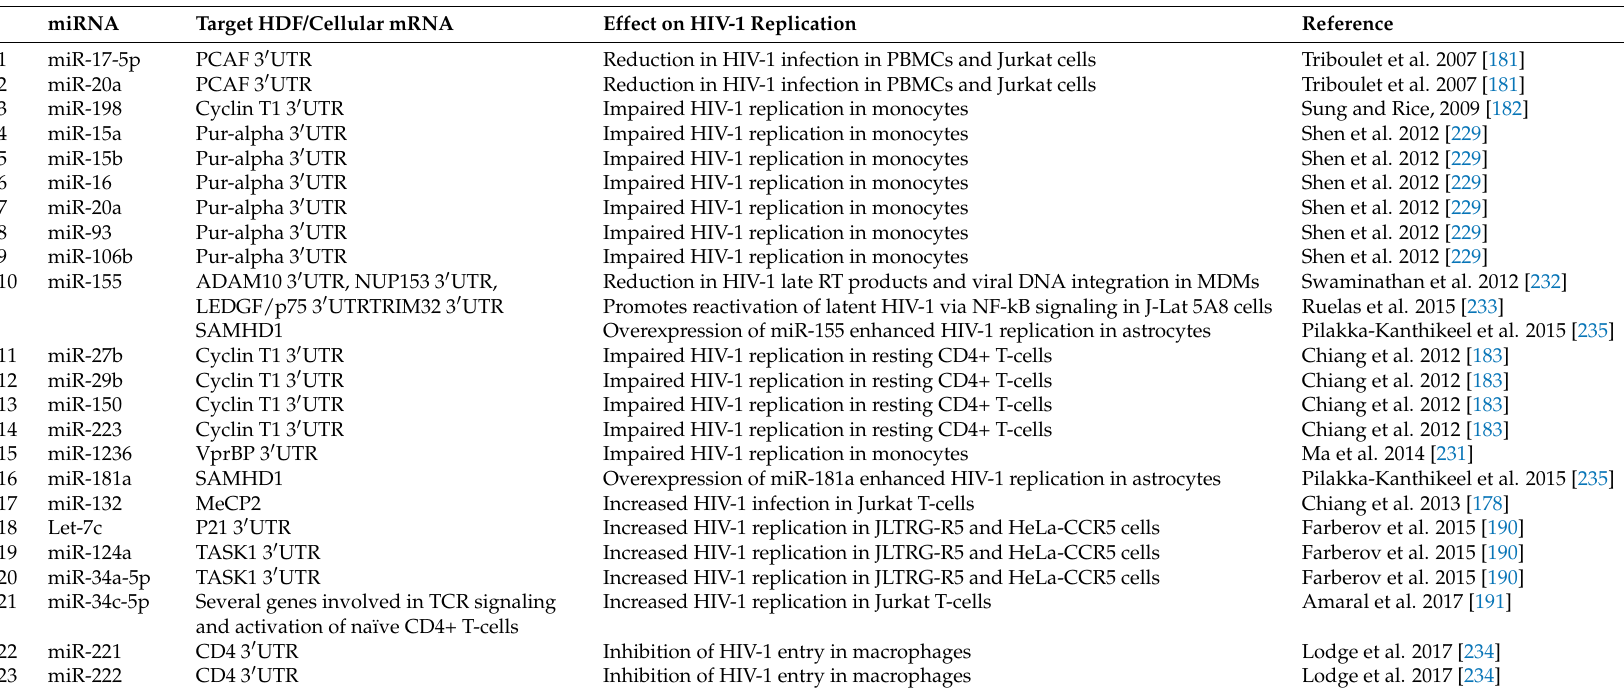
Table 2. Cellular miRNAs reported to target the host-dependency factors (HDFs) and modulate HIV-1 replication negatively or positively, and discussed in this review. miRNA Target HDF/Cellular mRNA Effect on HIV-1 Replication Reference